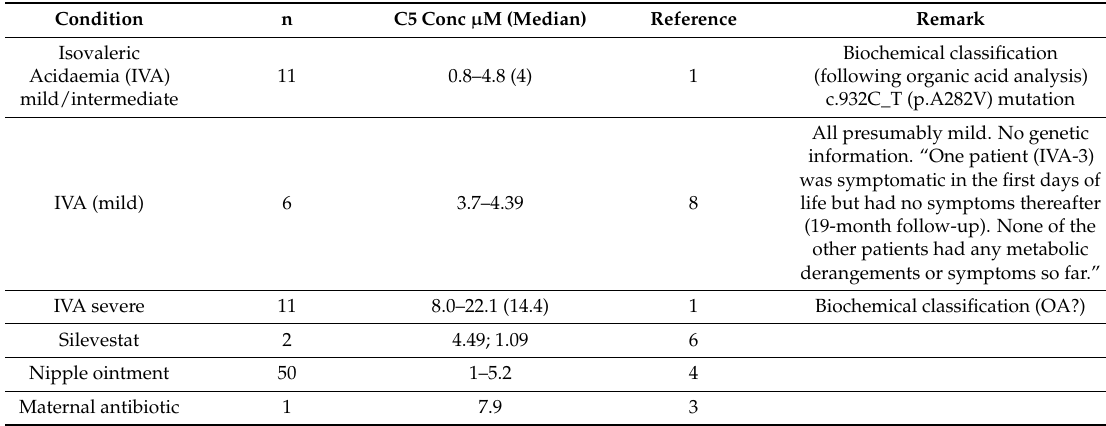
Table 3. C5 concentrations in newborn dried blood spot